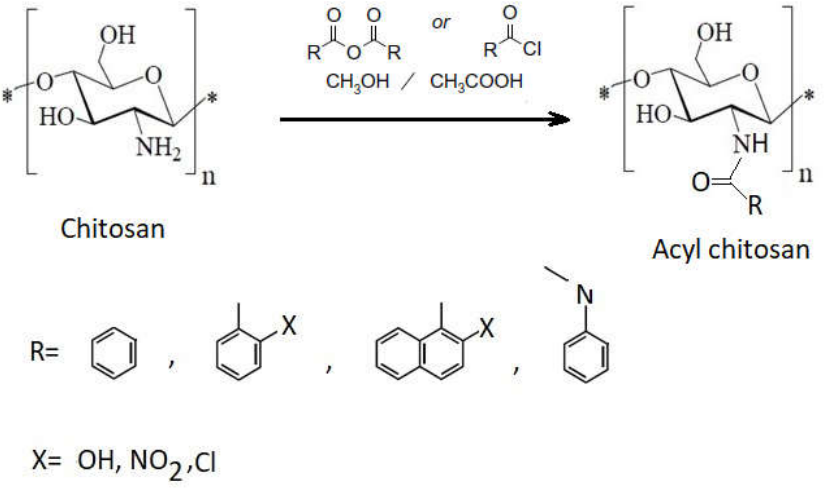
Figure 12. Schematic acylation of chitosan.